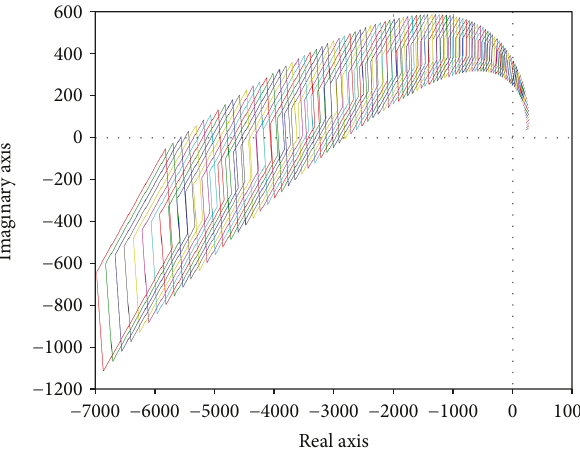
Figure 13: Envelope of Nyquist diagrams for FO plant family (29) and controller P = 1 46 .